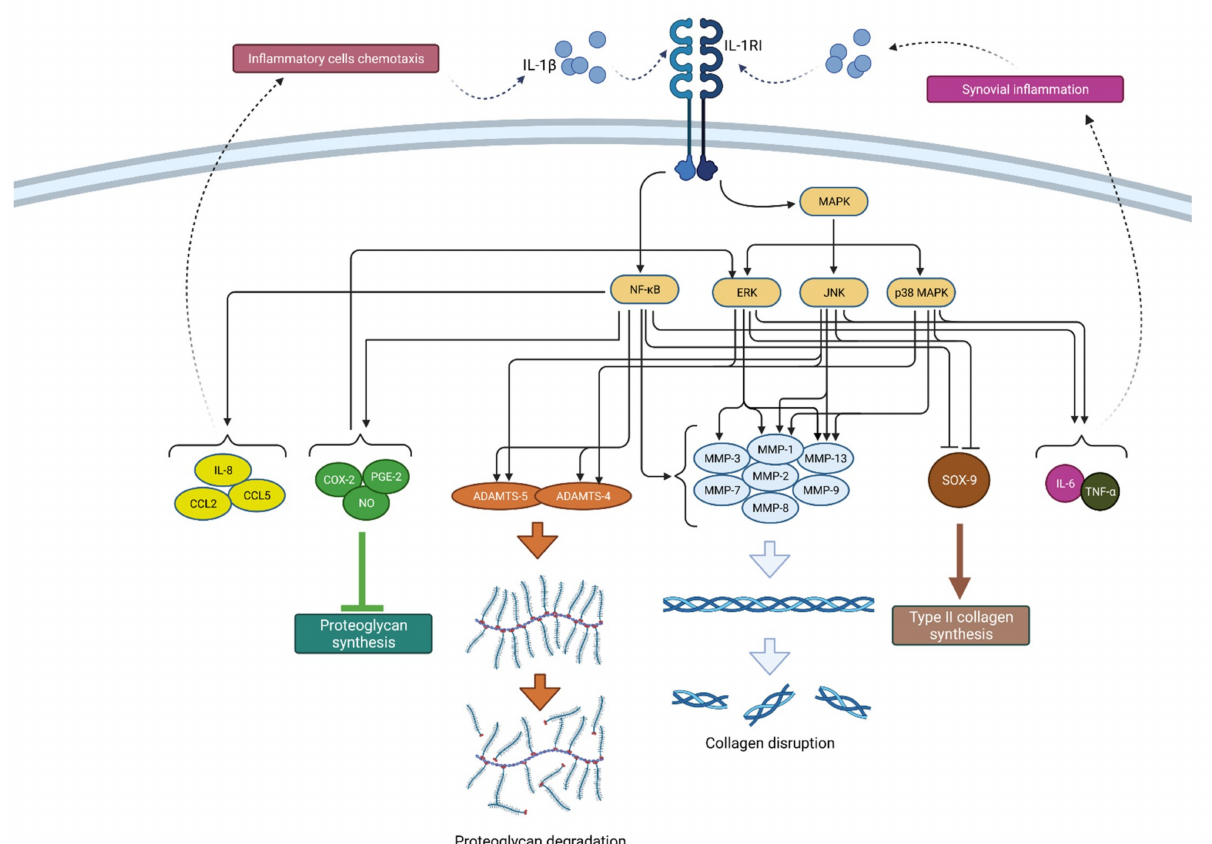
Figure 2. Schematic representation of IL-1 β function in osteoarthritis pathogenesis. By binding to its receptor (IL-1RI), IL-1 β activates signaling pathways (NF- κ B and MAPK) that, by raising the expression of enzymes (ADAMTS and MMPs), lead to catabolic reactions, i.e., proteoglycan degradation and collagen disruption. Furthermore, via the same signaling pathways, IL-1 β inhibits type II collagen synthesis through SOX-9 suppression but also proteoglycan synthesis by increasing the synthesis of COX-2, PGE-2 and NO. In addition, IL-1 β increases the expression of chemokines such as IL-8, CCL2 and CCL5, as well as the cytokines IL-6 and TNF- α , which attract inflammatory cells and cause synovial inflammation, respectively, resulting in the even greater production and secretion of IL-1 β . IL-1 β —interleukin 1 β ; IL-1RI—interleukin 1 receptor 1; MAPK—mitogen-activated protein kinase; ERK—extracellular signal-regulated kinases; JNK—c-Jun N- terminal kinases; NF- κ B—nuclear factor kappa-light-chain-enhancer of activated B cells; MMPs—matrix metalloproteinases (MMPs); ADAMTS—a disintegrin-like and metalloproteinase with thrombospondin motif;